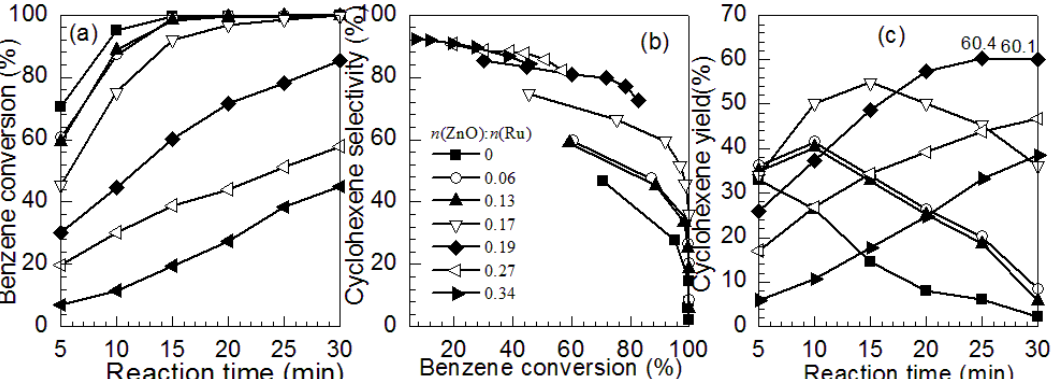
Figure 6. Catalytic activity towards cyclohexene formation from selective hydrogenation of benzene over Ru-4.7 catalyst with the different molar ratio of ZnO to Ru in the presence of ZnSO 4 ( m cat = 2.0 g, m ZnSO4 = 50.0 g, v H2O = 280 mL, v benzene = 140 mL, T = 423 K, p H2 = 5.0 MPa). ( a ) catalytic activity towards benzene conversion over Ru-4.7 catalyst, ( b ) catalytic selectivity towards cyclohexene formation and ( c ) yield of cyclohexene over Ru-4.7 catalyst with the different molar ratio of ZnO to Ru in the presence of ZnSO 4 .